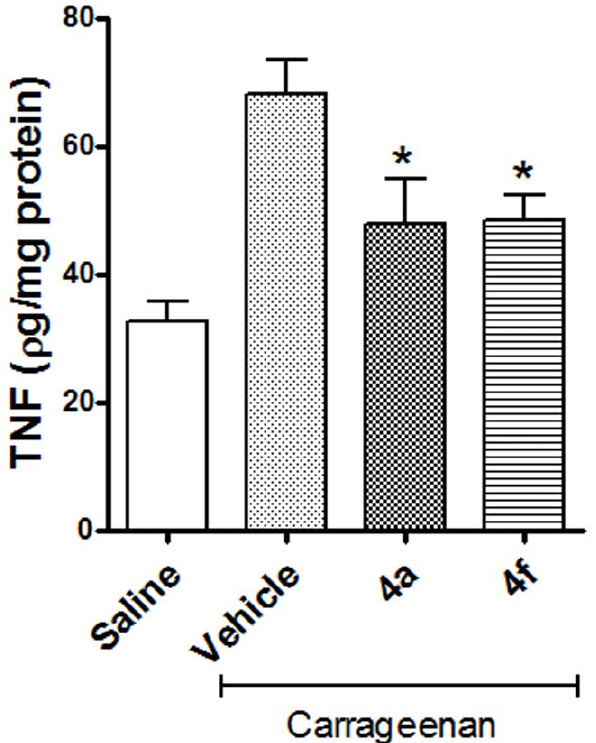
Figure 7. Effects of 4a, 4b, 4c, 4f and SB-203580 (100 m mol/kg, p.o.) on carrageenan-induced thermal hyperalgesia. n=5–10 animals per group, the test groups were compared to the vehicle control group using two-way analysis of variance (ANOVA) followed by Bonferroni post hoc test, *p , 0.05, ***p , 0.001.